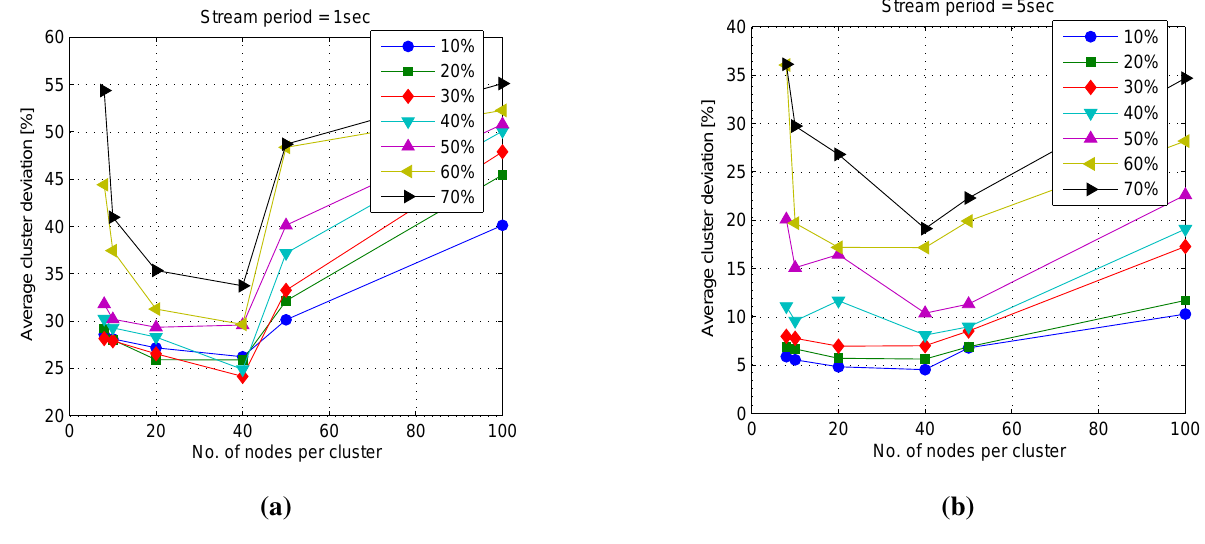
Figure 11. Average of cluster deviations for different stream